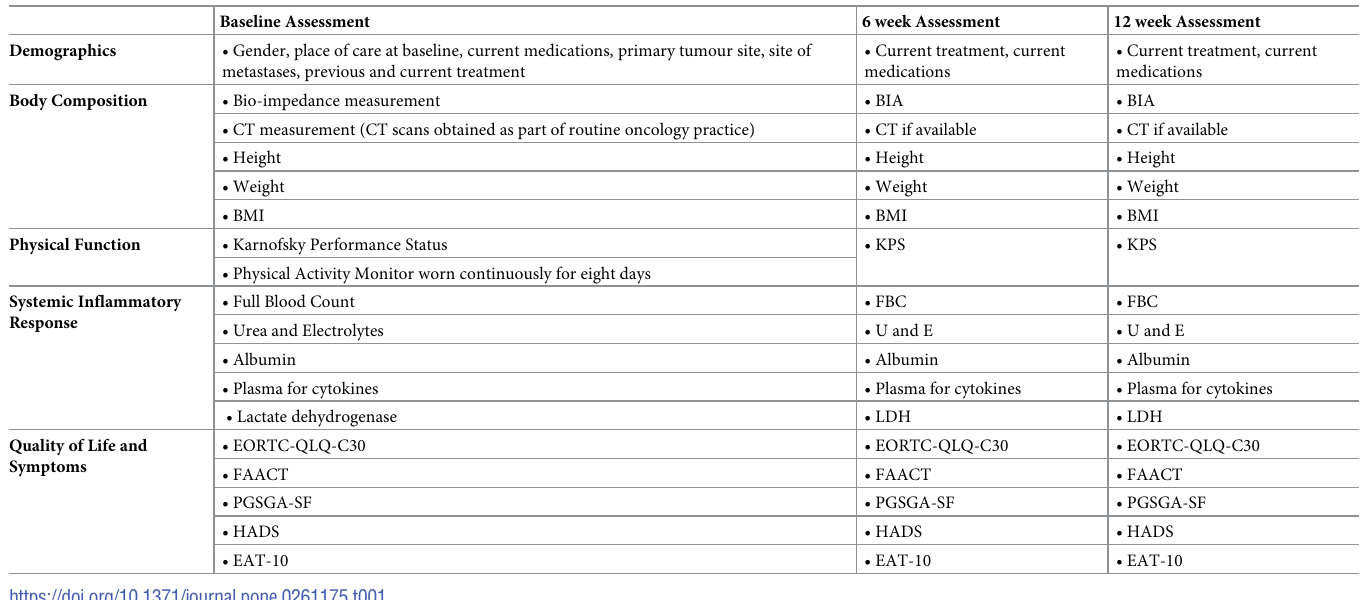
Table 1. Study assessments and time points.